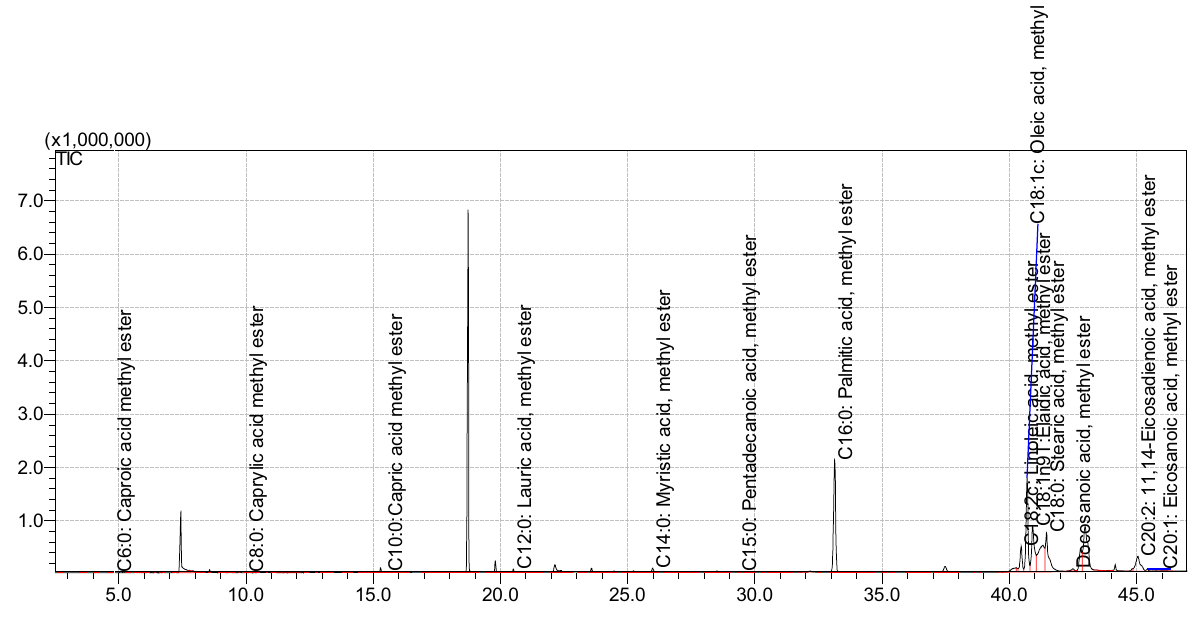
Figure 1: GC - MS analysis of oil extracted from HO fraction of F. benghalensis.